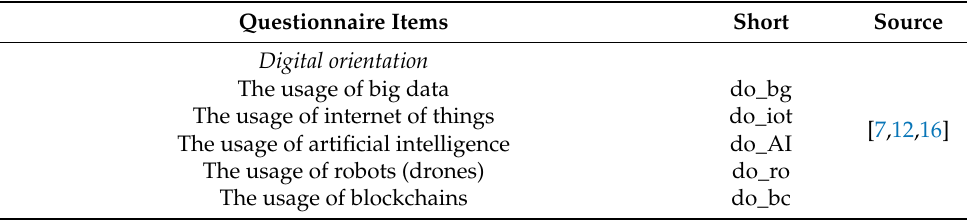
Table 1. Measurement